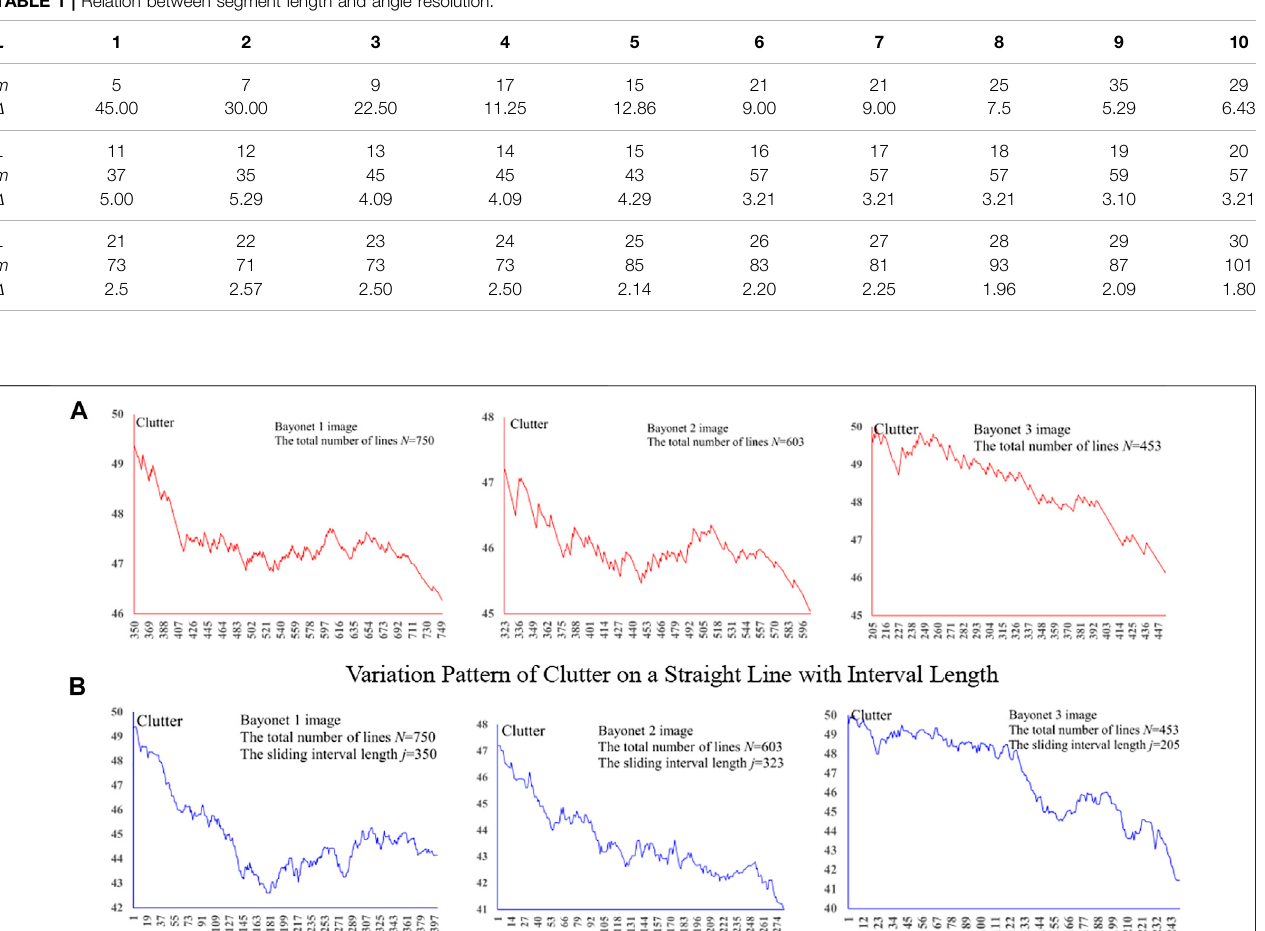
Frontiers in Bioengineering and Biotechnology |